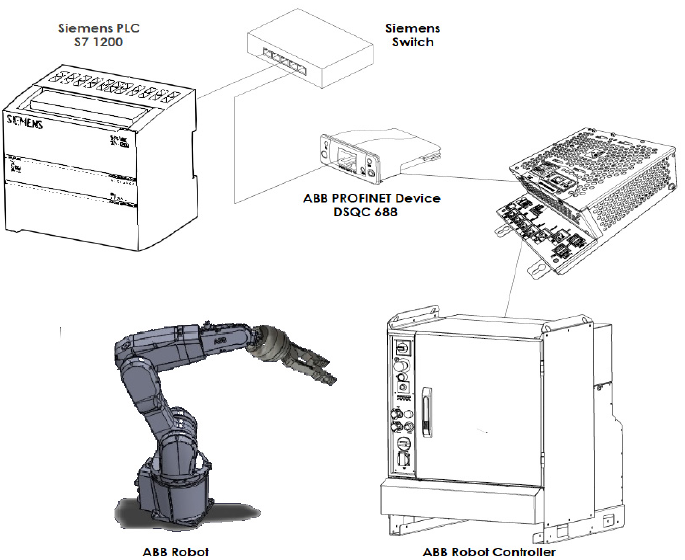
Figure 4. Profinet communication link between Siemens S7-1200 PLC and ABB Robot Controller.